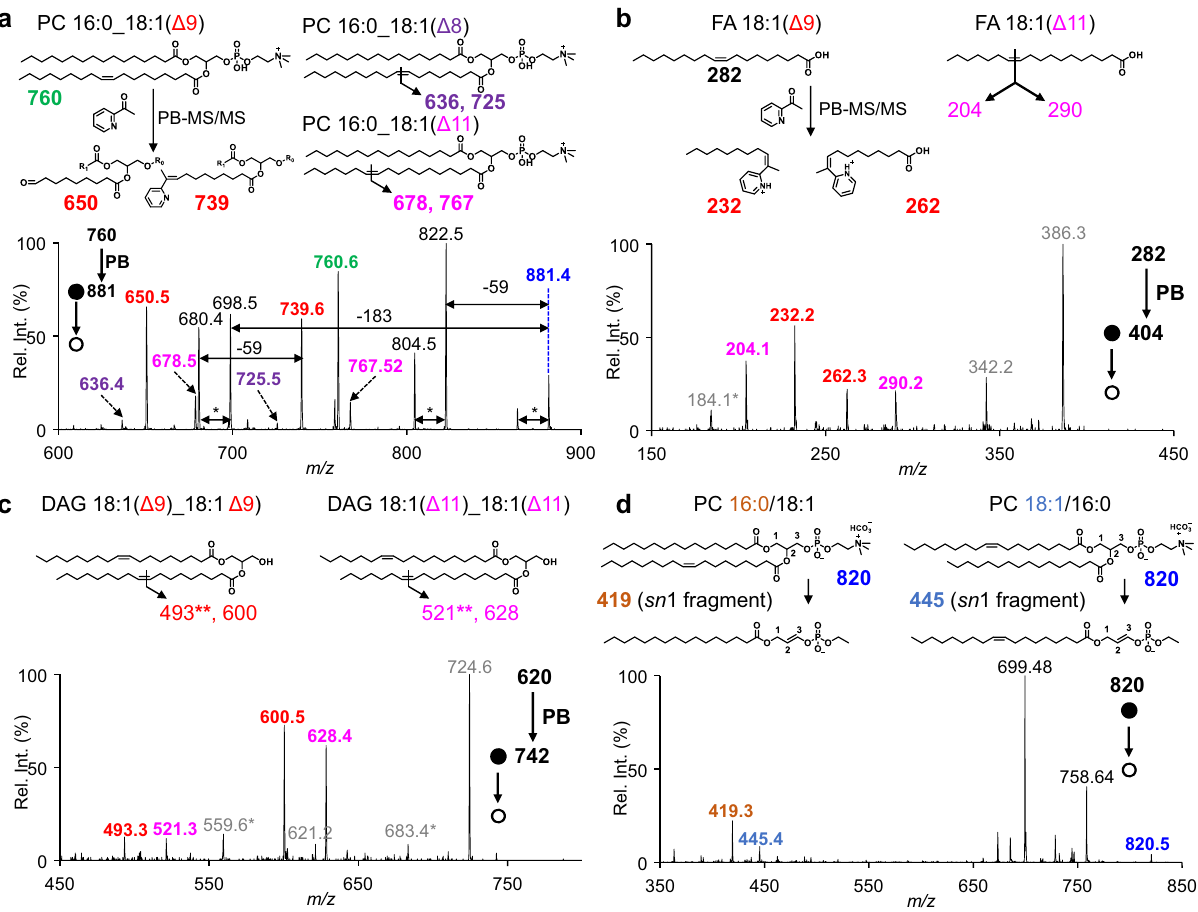
Fig. 3 Lipid structural elucidation in single cells. a Chemical structure of C = C location and their speci fi c diagnostic ions for PC 16:0_18:1, where the C = C in C18:1 was located at 8, 9, or 11 and the MS/MS spectra of PB (PC 16: 0_18:1) ( m/z 881.5) from a single MDA-MB-231 cell. The symbol * indicated a loss of H 2 O. b, c Chemical structure of C = C location and their speci fi c diagnostic ions for FA 18:1 ( b ) and DAG (18:1_18:1) ( c ), where the C = C in C18:1 was located at 9 or 11 and the corresponding MS/MS spectra of PB (FA 18:1) ( m/z 282.3) and PB (DAG 18:1_18:1) ( m/z 620.5) from a single MCF-7 cell. *Fragment ions characteristic to PCs ( m/z 184 and the signals due to neutral losses of 59 and 183 Da) are detected alongside with FA and DAG. This can be explained by the co-isolation of isobaric PC(s) to the lipid of interests. d Chemical structure of PC 16:0/18:1 and PC 18:1/16:0, their diagnostic ions generated by negative ion mode MS/MS analysis with the adduct of bicarbonate anion and the MS/MS spectra of [PC 34:1 + HCO 3 ] − ( m/z 820) in a single MDA-MB-231 cell. All diagnostic ions in the MS/MS spectrum are labeled with the same color as in the corresponding chemical structures.